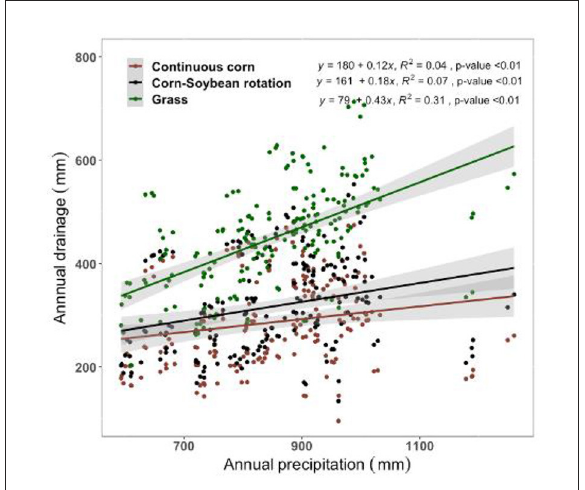
FIGURE2 Multiple linear regression between annual drainage and annual precipitation across the three vegetation types investigated. The grass system showed a stronger positive relationship between annual drainage and precipitation.